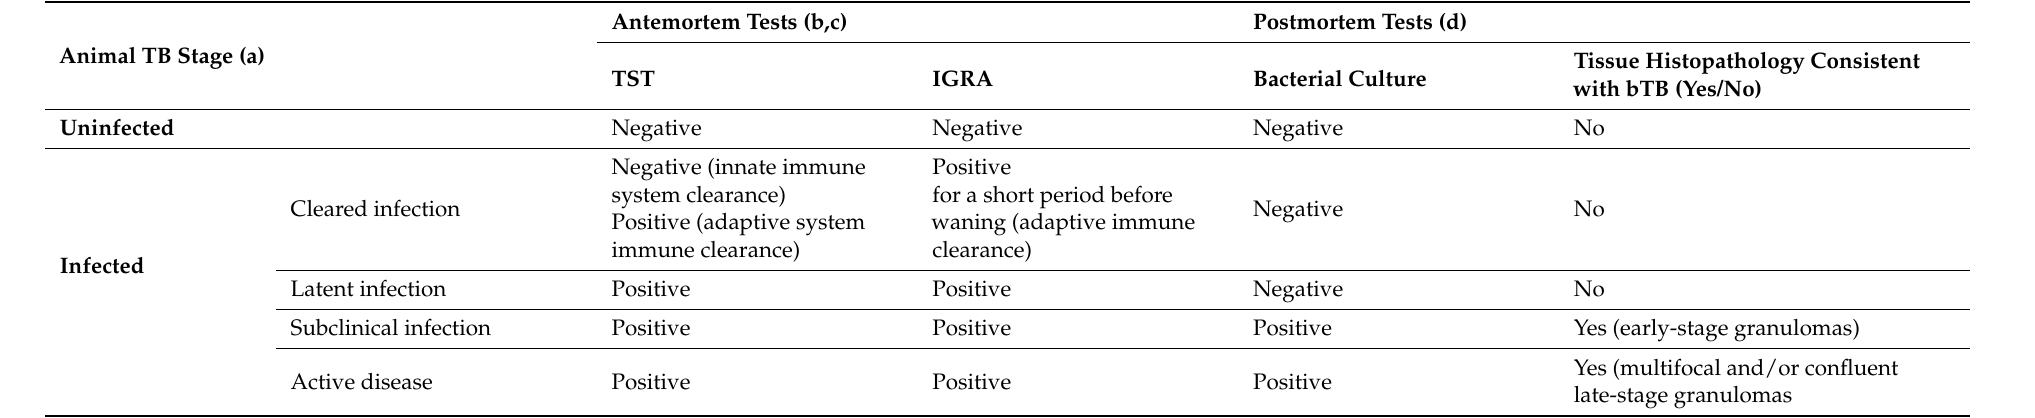
Table 3. Hypothetical infection stages and associated antemortem and postmortem test results for categorising TB stages.